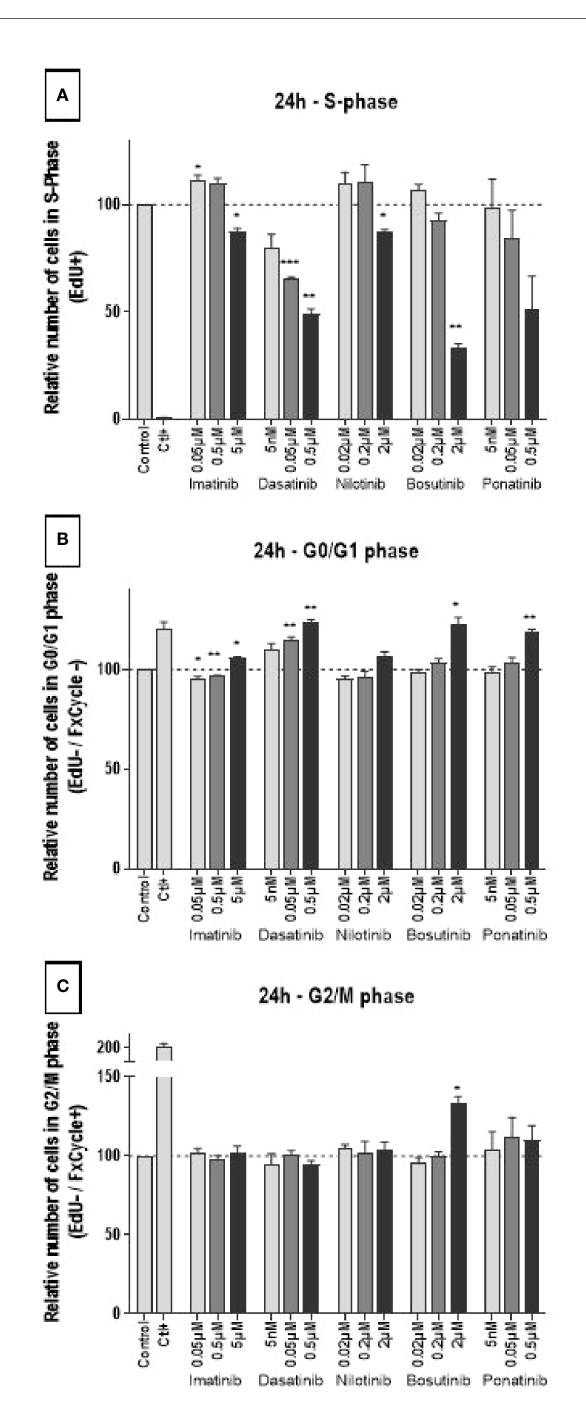
FIGURE 3 | All BCR-ABL TKIs inhibit HUVEC proliferation. Cell cycle analysis was performed on HUVECs exposed to BCR-ABL TKIs for 24 h in medium with 10% dialyzed FBS by measuring EdU incorporation and DNA content (FxCycle). Histograms represent cells in S-phase (A) , G0/G1 phase (B) , and G2/M phase (C) . Bars represent the means of the three experiments ± SEM. Three concentrations were tested for each TKI. Results are expressed relative to control (DMSO 0.2%). Differences between conditions were tested using a one sample t-test that compared each TKI condition versus control. *p < 0.05 and **p < 0.01.